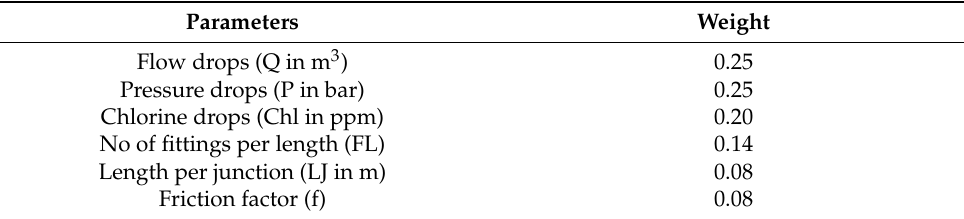
Table 5. Parameters assigned weights.